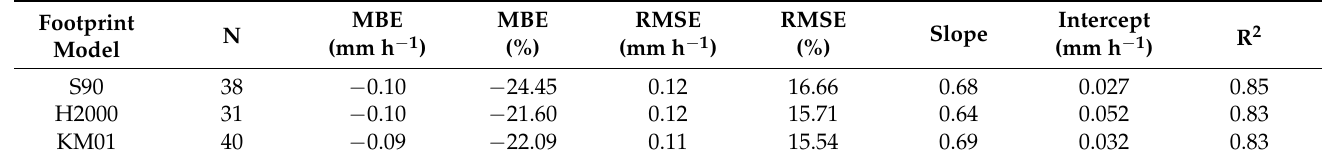
Table 3. Comparison of the composite ET to the ET from EC8.